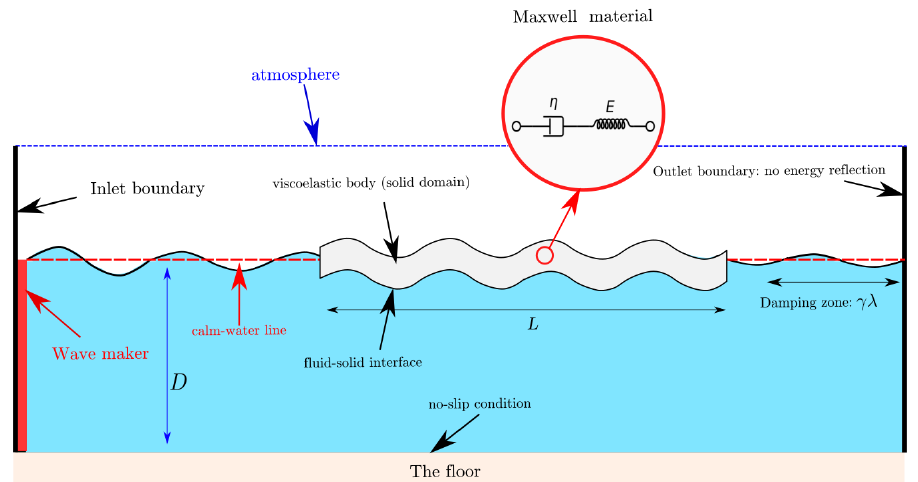
Figure 2. A sketch of the computational domain used to numerically reproduce the interaction between water waves and a viscoelastic cover. A Maxwell model, as shown in the circle, is employed to calculate the stresses emerging in the solid domain.